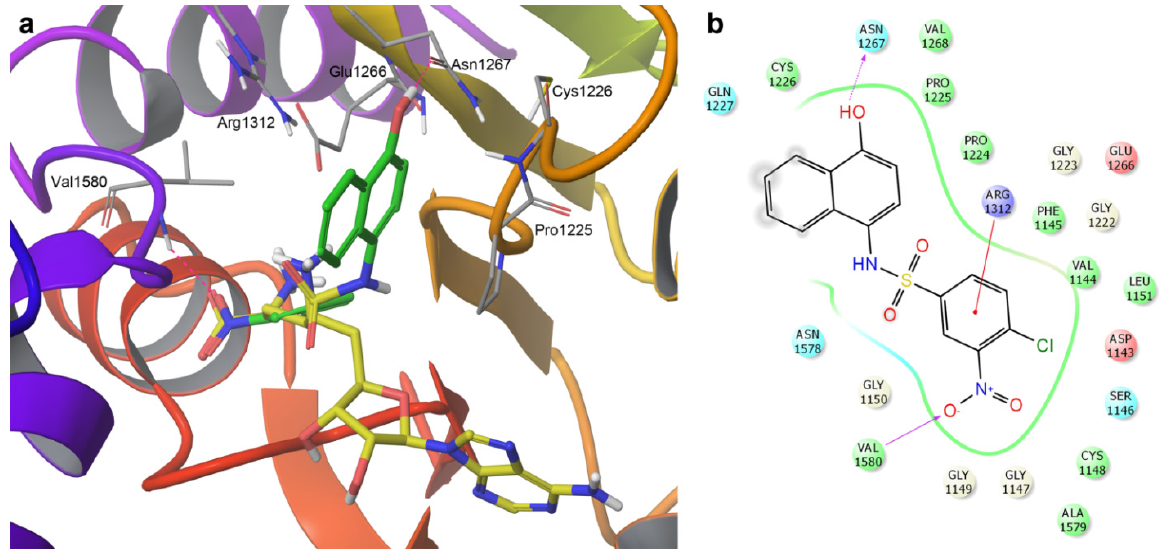
Figure 4. ( a ) Induced-fit docking pose of SW155246 (carbon atoms in green) with human DNMT1. The co-crystal sinefungin (carbon atoms in yellow) is shown for reference; ( b ) Two-dimensional interaction diagram of the binding model of SW155246 . Acidic, hydrophobic, basic, polar, and other residues at the active site are represented by red, green, purple, blue, and gray spheres, respectively. Hydrogen bonds between the ligand and backbone or side chains are shown in dashed pink lines. The π -cation interaction is shown with a red